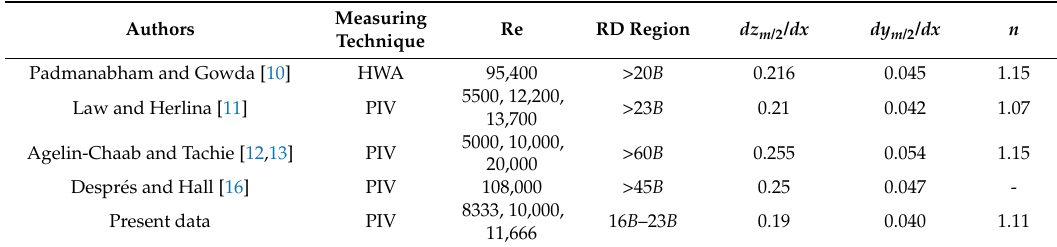
Table 1. Illustration of previous studies on three-dimensional wall